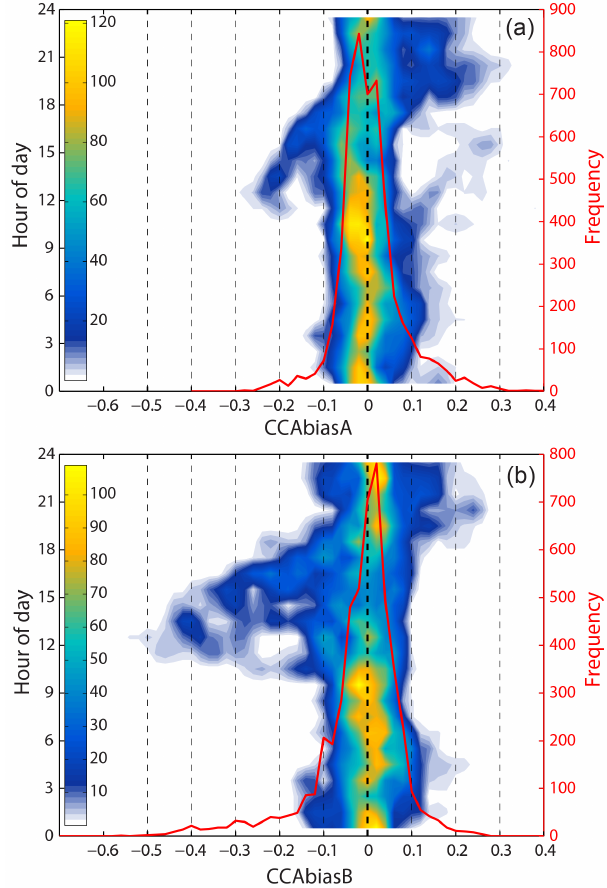
Figure 7. Two-dimensional frequency distribution (number of oc- currences per interval of CCNbias and time of day, shown as con- tour plot) and overall frequency distribution (number of occurrences per interval of CCNbias, shown as red line) of CCNbiasA (a) and CCNbiasB (b) for the entire campaign